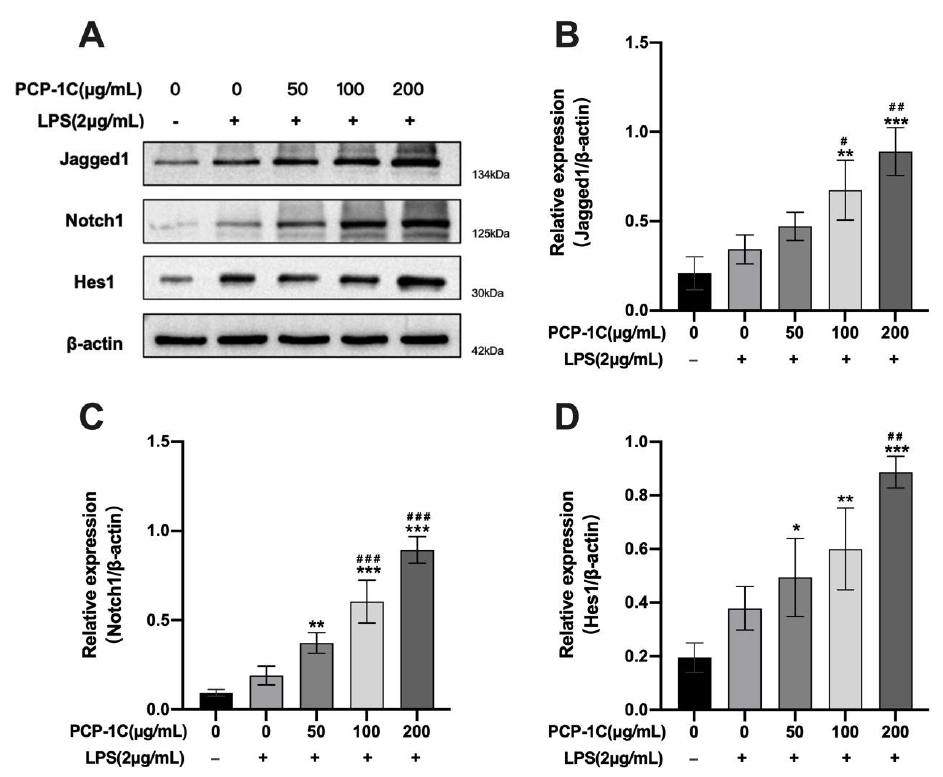
Figure 8. Western blot detection of Notch signaling pathway in RAW 264.7 cells. RAW 264.7 cells were stimulated with 50 µ g/mL, 100 µ g/mL, and 200 µ g/mL PCP-1C and/or 2 µ g/mL LPS for 24 h. Cell extracts were then prepared followed by Western blotting ( A ), which was performed using antibodies specific for Notch1 ( C ), Hes1 ( D ), and Jagged1 ( B ). * p < 0.05, ** p < 0.01, *** p < 0.001 vs. Control, # p < 0.05, ## p < 0.01, ### p < 0.001 vs. LPS; “ + ” indicates the cells were treated with LPS, while “−” indicates they were treated without LPS.